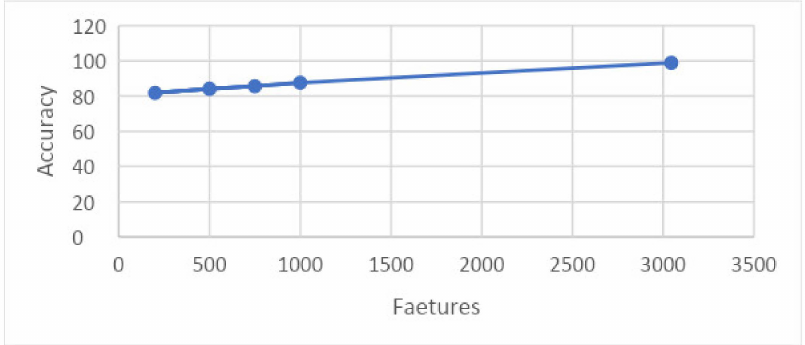
Figure 21. Graph showing accuracy and features on 5-fold.